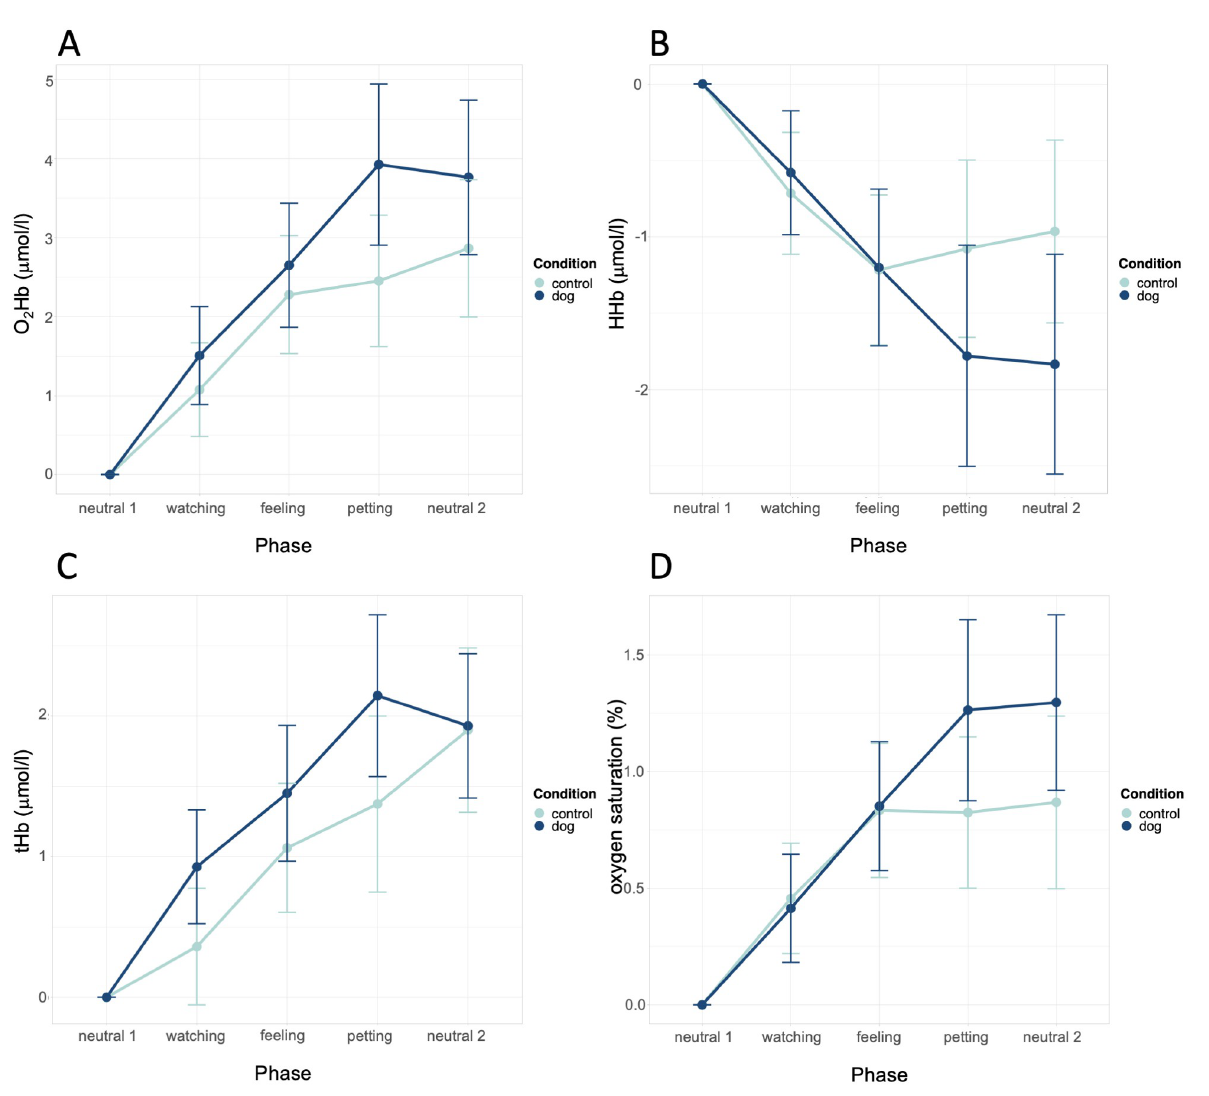
Fig 3. Effects of condition and phase on O 2 Hb, HHb, tHb, and oxygen saturation. (A) O 2 Hb, (B) HHb, (C) tHb, and (D) oxygen saturation. Error bars denote confidence interval. Data is shown as relative change from phase neutral 1.